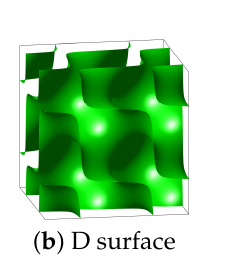
Figure 15. Triply periodic minimal surfaces: P, D, and G.